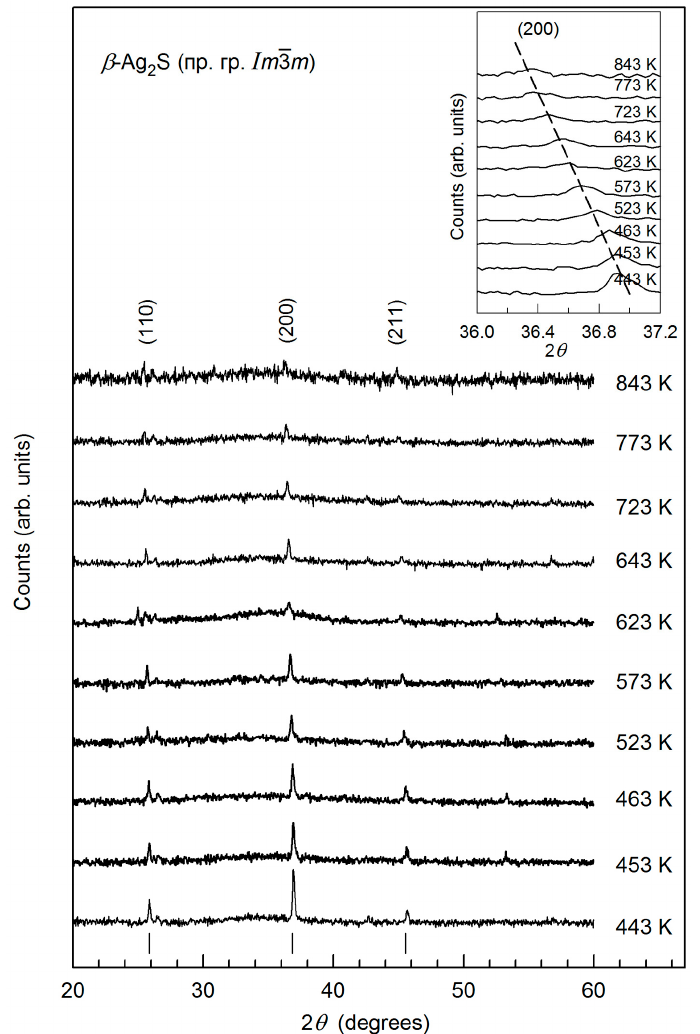
Figure 3. Change of XRD patterns of fine-dispersed argentite β -Ag 2 S in the region 443–843 K. As an example, a shift of (200) diffraction reflection with temperature increasing is shown on inset.